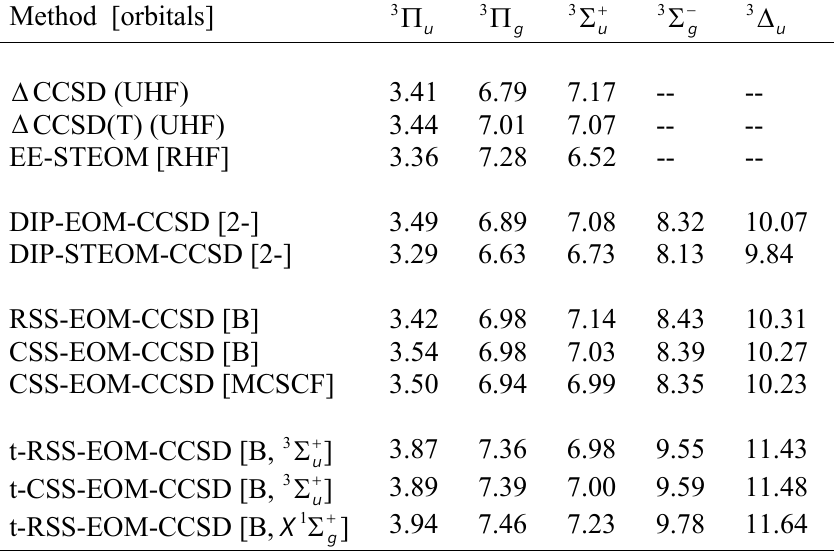
Table VI. Triplet excitation energies (in eV) for F (cc-pVTZ basis, R=141.36